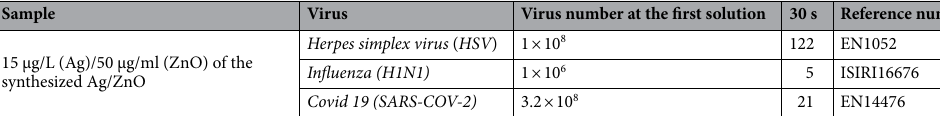
Table 5. The effect of synthesized nanomaterials on examined viruses.